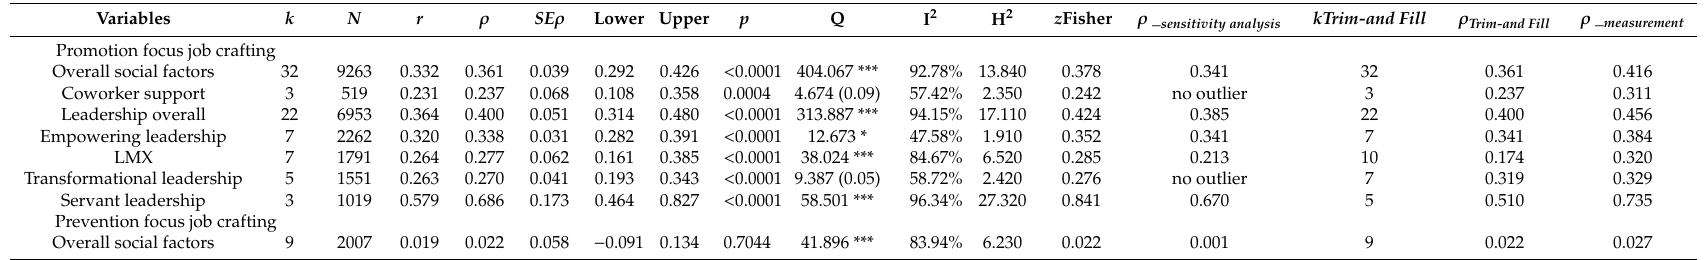
Table 1. Summary of meta-analytic relationships: social factors as correlates of job crafting (H1). Variables Promotion focus job crafting Overall social factors